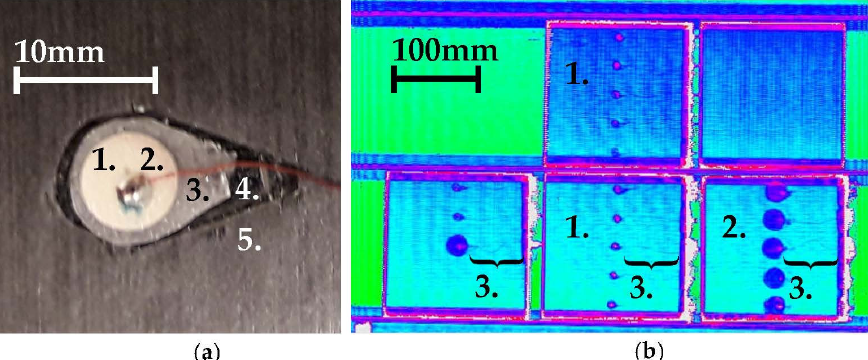
Figure 1. Manufacture of the specimens: ( a ) Close ‐ up view of a ‘small’ sensor being embedded. Numbers 1 to 5 relate to the PWAS, solder and wiring, GFRP insulation, CFRP cut out and CFRP host material respectively. ( b ) C ‐ scan after curing of CFRP panels with embedded sensors. Specimens were cut to width afterwards. Numbers 1 to 3 refer to panels with small embedded sensors, panels with larger embedded sensors and embedded wiring.